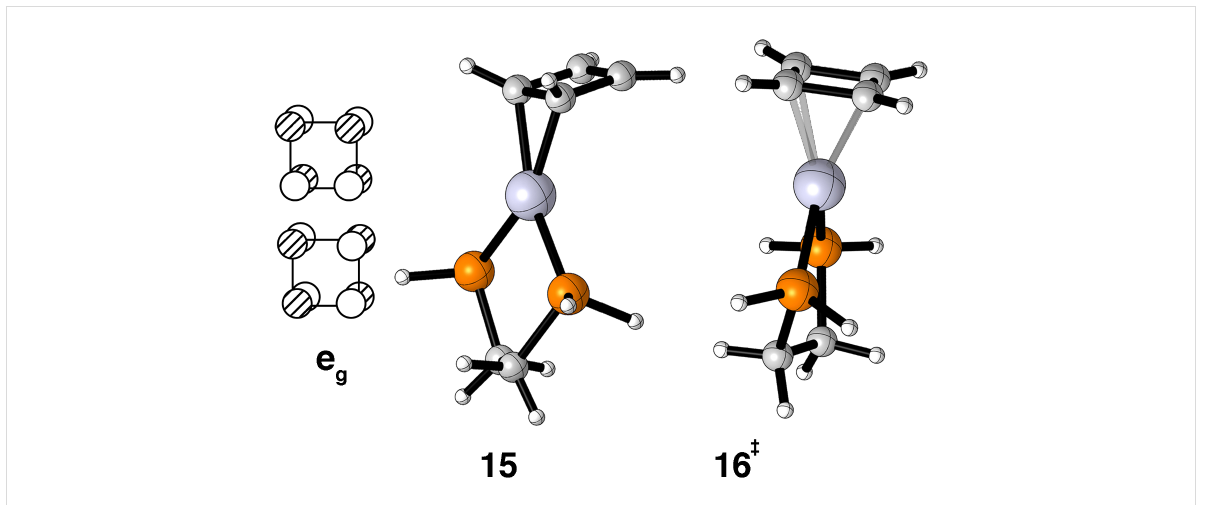
Figure 6: The ground and transition state for ring whizzing in F 6 C 6 –Pt(dpe), 17 and 20 , respectively. The dominant bonding interac- tion for two possible transition states, 18 and 19 along with the HOMO, 21 and LUMO, 22 , in the η 1 transition